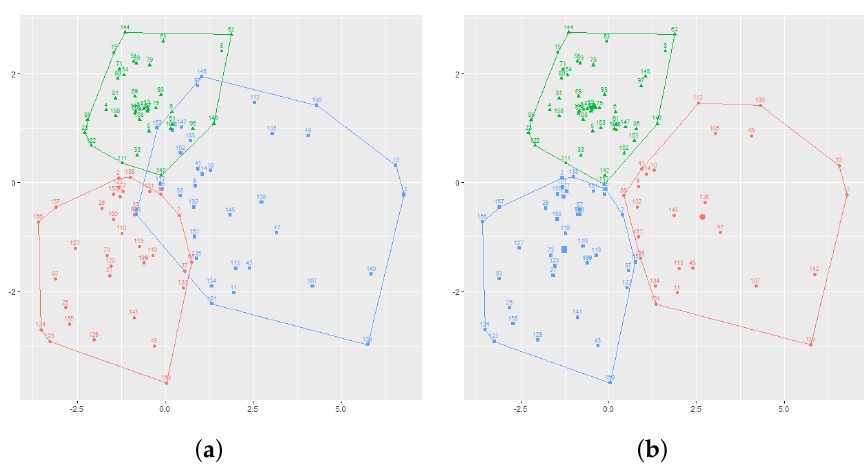
Figure 1. Crop partitions for Kalundborg. The first and second components appear along the horizontal and vertical axes, respectively. ( a ) K-medoids for Kalundborg. ( b ) Fuzzy K-means for